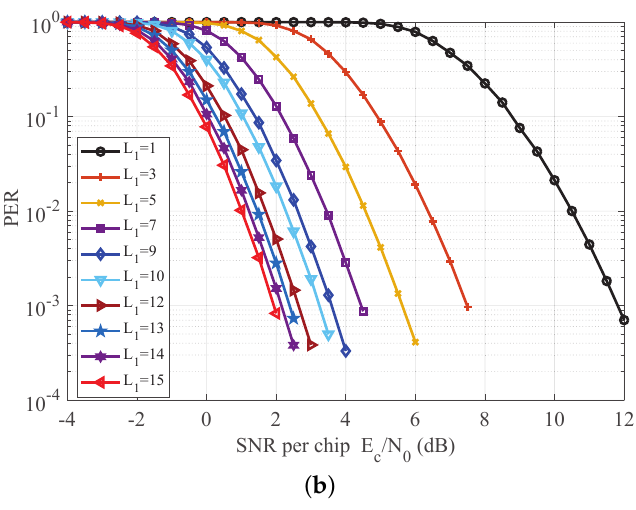
Figure 6. Performance impact of parameter L 1 . ( a ) BER impact of L 1 ; ( b ) PER impact of L 1 .